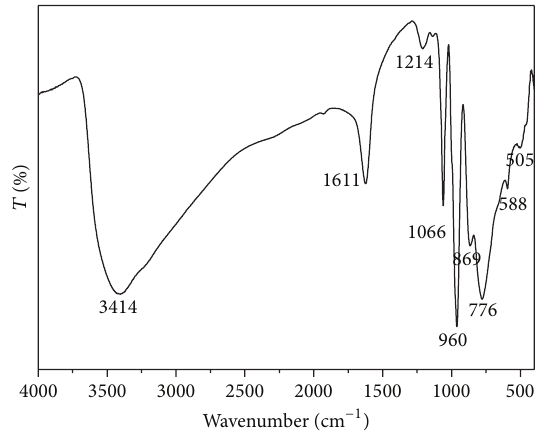
Table 1: The inhibitory effect of PMo